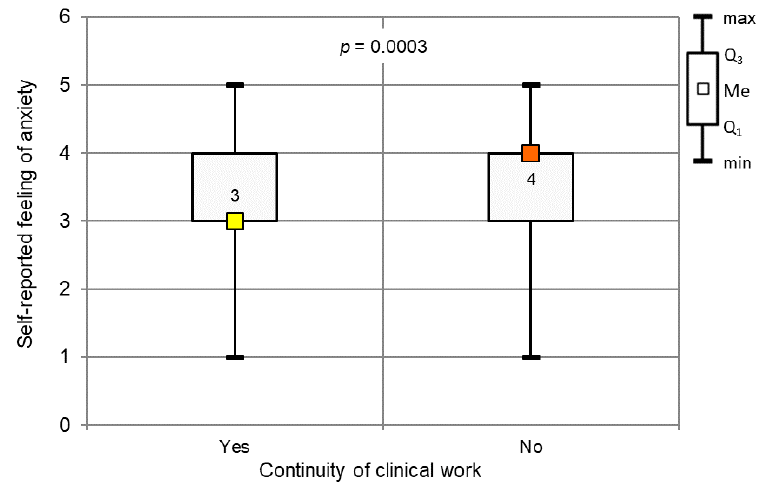
Figure 3. Continuity of clinical work during the COVID-19 outbreak vs. self-reported anxiety level ( p < 0.001, Mann–Whitney test).